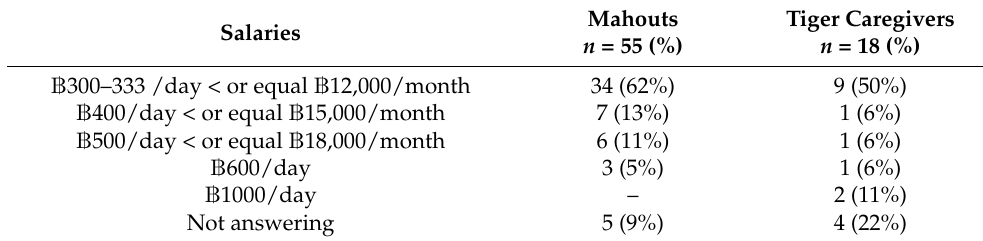
Table 3. Salaries reported by mahouts and tiger